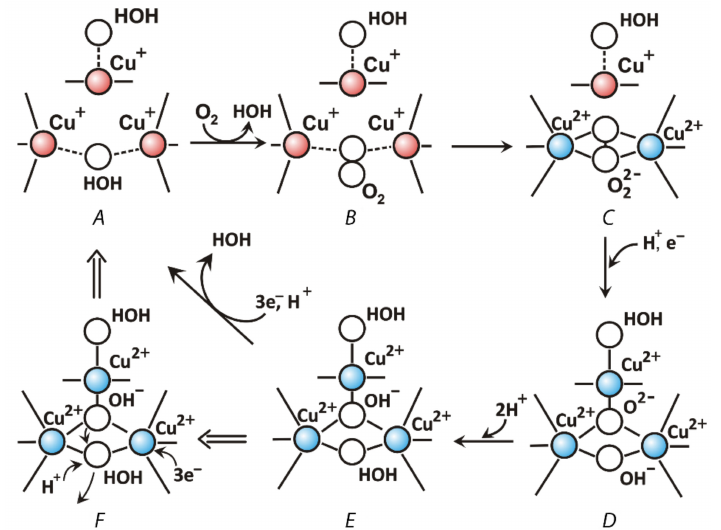
Figure 6. Mechanism of molecular oxygen reduction by laccases to water: O 2 + 4e − + 4H + → 2H 2 O. Intermediate states are shown in Figure ( A – F ). Panel F shows the mechanism of the release of a water molecule from the TNC. Coordination and covalent bonds are shown by solid lines. Ion-dipole electrostatic interactions are shown with dotted